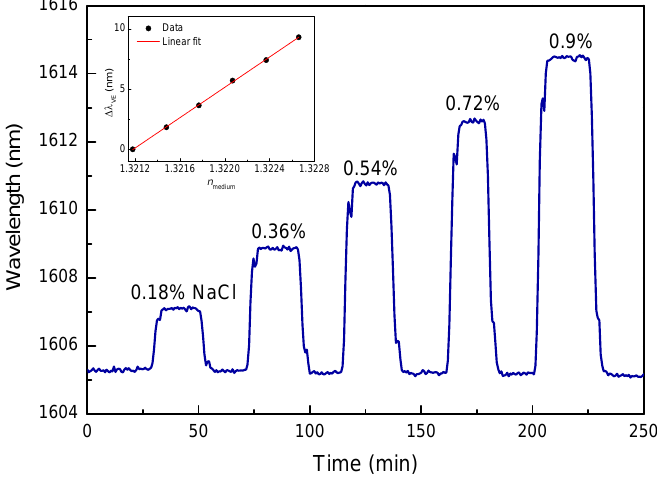
Figure 5. Real-time monitoring of the Vernier envelope for different NaCl solutions in DI water. (Inset) the linear fit (red line) of the wavelength shift vs. the refractive index corresponding to the range of NaCl concentrations of 0%–0.9%.